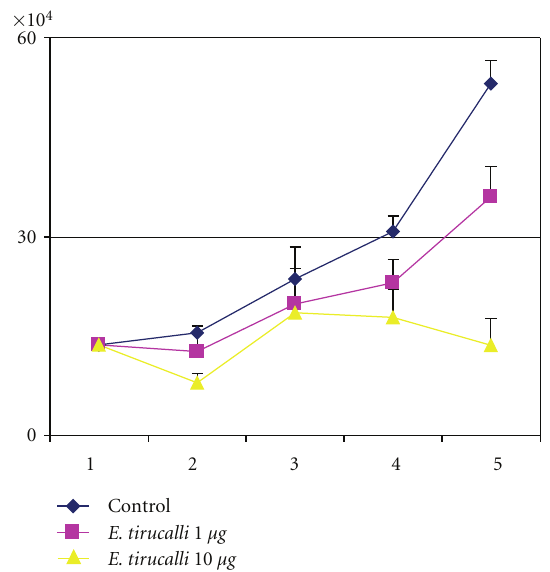
Figure 2: To rule out the possibility that the decrease of cell prolif- eration and the concomitant increase in cell death observed in E. tirucalli -treated cells was due to induction of the lytic pathway of EBV, an EBV-negative cell line (Ramos) was cultured in the same experimental conditions as cord blood derived cells. E. tirucalli treatment had the same e ff ects on cell proliferation and cell death, independently of EBV status. Treated cells showed a decreased cell proliferation ( P < 0 . 05). The graph is representative of three di ff erent experiments. Error bars represent standard deviation be- tween